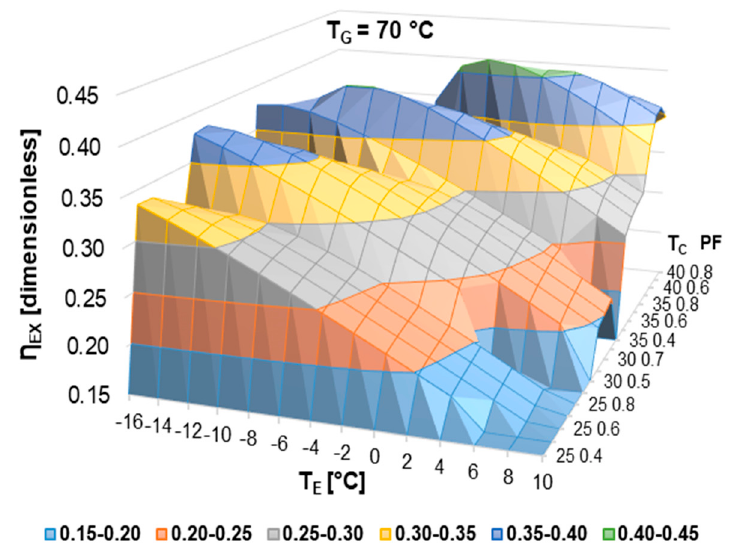
Fi gure 14. Exergy efficiency ( (cid:31) Ex ) against T E and PF for different T C . Analyzed case: T G = 70 °C. Figure 14. Exergy efficiency ( η Ex ) against T E and PF for different T C . Analyzed case: T G = 70 ◦